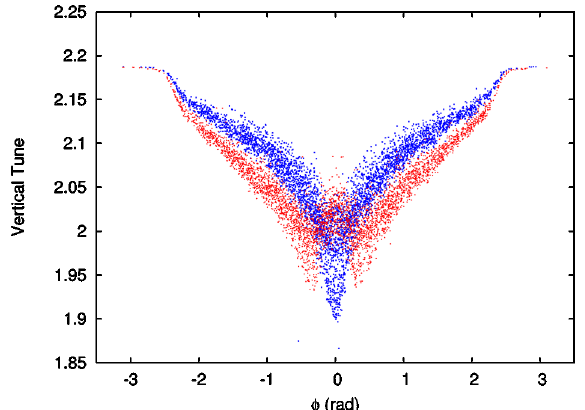
FIG. 11. (Color) Experimental transverse vertical profile mea- surements of the full intensity beam. The (blue) dashed curve is the profile of the beam without the longitudinal notch, and the (red) solid curve is the profile of the beam with the longitudinal